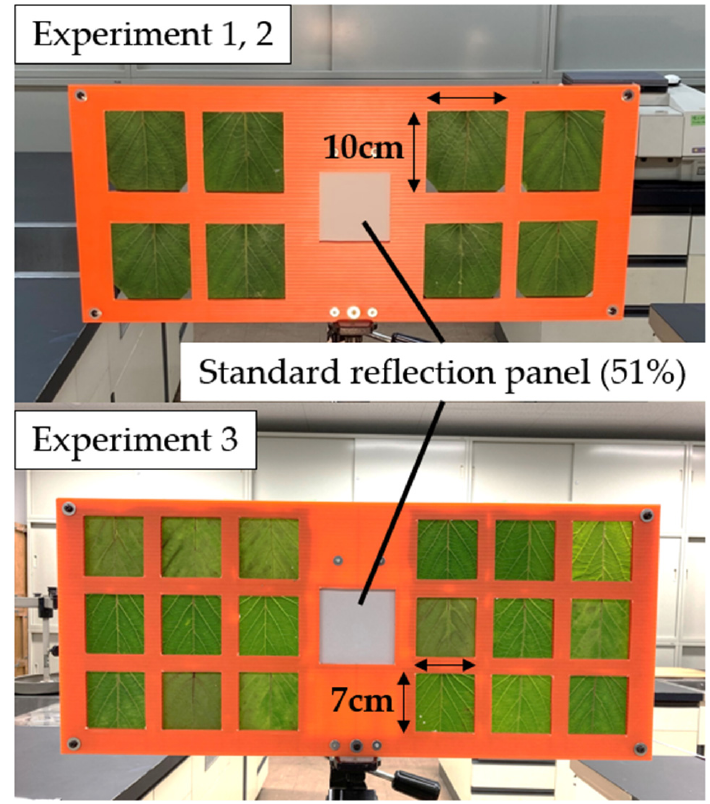
Figure 2. The images of leaf samples.